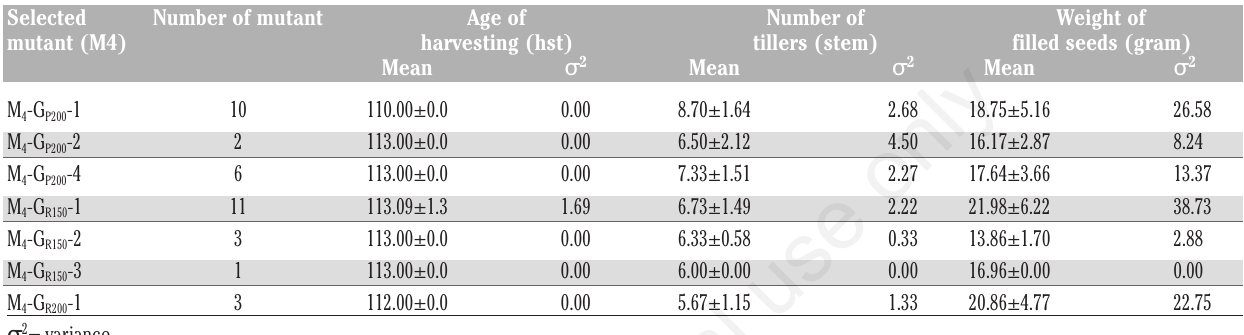
in Table 1. Mutant varieties originated from South Sulawesi have higher number of tillers, number of filled seeds and higher yield than the previous. Harvesting age of mutant is shorter than previous. 11 M4 has a high diversi- ty in their traits of filled seed weight (Table 2). M4 should be further selected so that the weights of produced seeds were more stable. Previous study showed no increase in weight of filled seeds of mutant compared to previous. 16 Mutants undergo decreasing weight of 1000 seeds. M4 has shown the character of stable har- vesting age with early ripening. An effective Table 2. Mean, standard deviation and variance of the Selected M4. Selected Number of mutant Age of